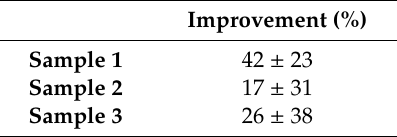
Table 5. Calculated improvement of Extracellular Vesicle (EV) isolation yields,